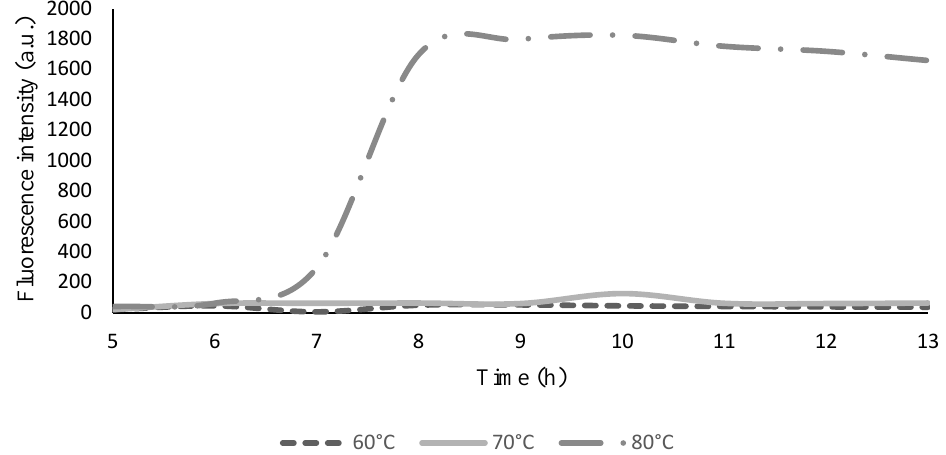
Figure 1. Effect of temperature on pyroglutamic acid (60 µ M) formation as a function of time.